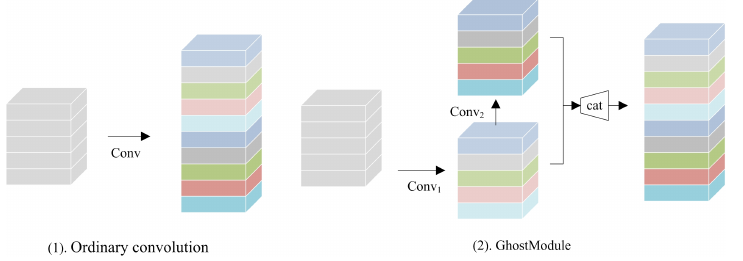
Figure 1. Ordinary convolution ( 1 ) and GhostModule ( 2